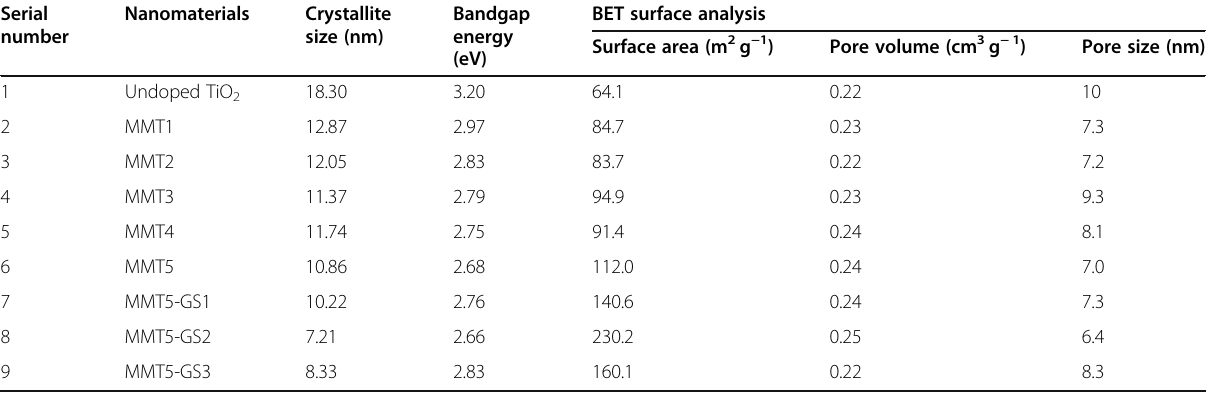
Table 2 Crystallite size, band gap energy and BET surface area of undoped TiO 2 and all bimetal doped and surfactant-assisted TiO 2 catalysts calcined at 450